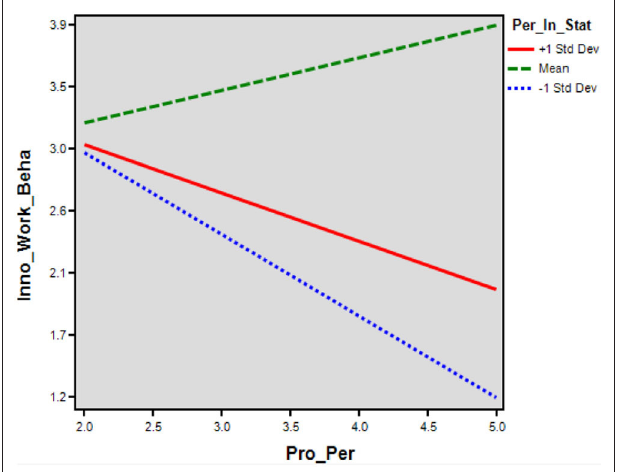
FIGURE 5 | Direct effects. Source: generated through interaction software.